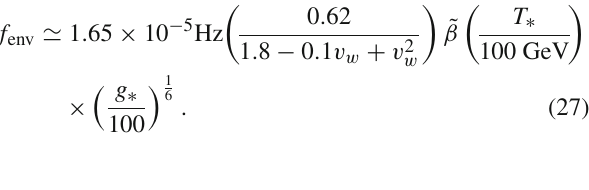
Fig. 3 An example of two first-order PTs, the first is along the s - direction followed by the second which is along the mixing direc- tion (notice the zoomed-in plots). This is given by the parameters